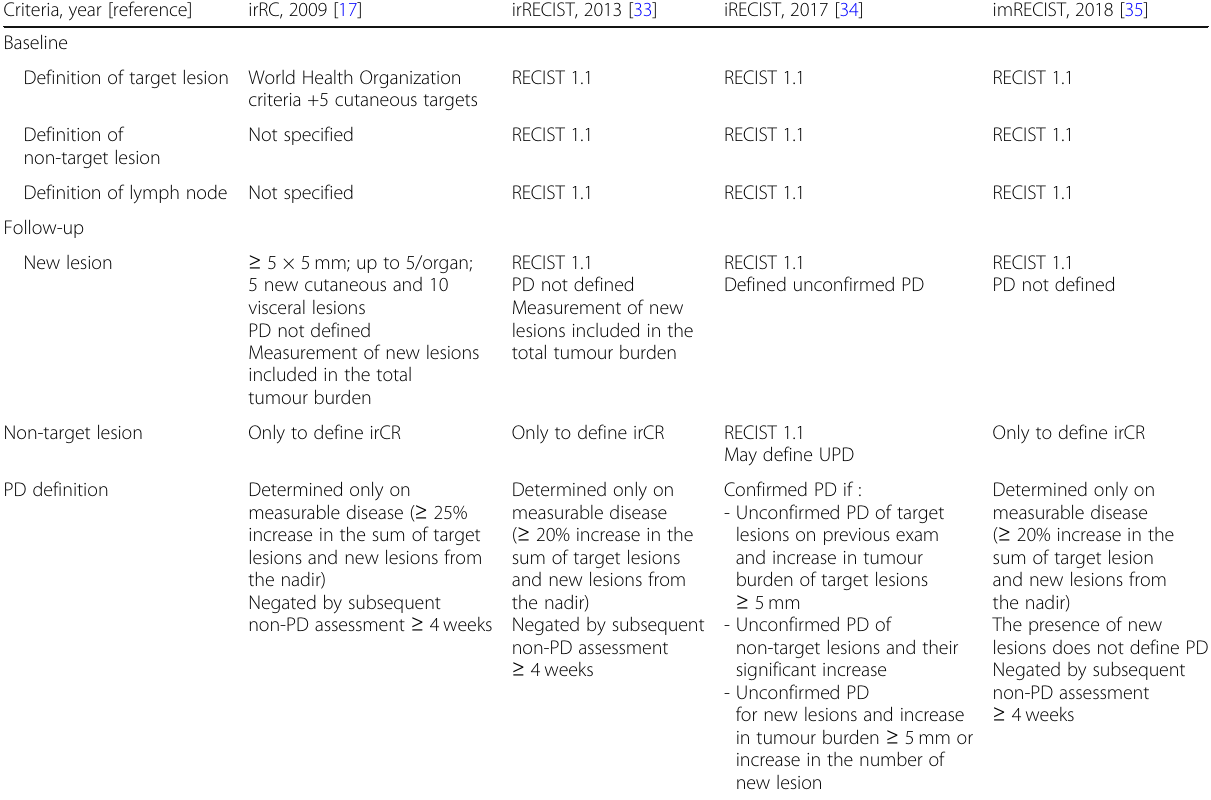
Table 3 Comparison of the different criteria developed for the assessment of response to immunotherapy Criteria, year